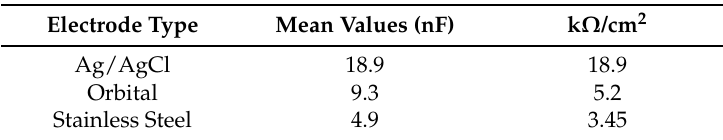
Table 3. Ag/AgCl, Orbital and stainless steel electrodes’ circuit component C d average values (nF) for all the tested subjects.